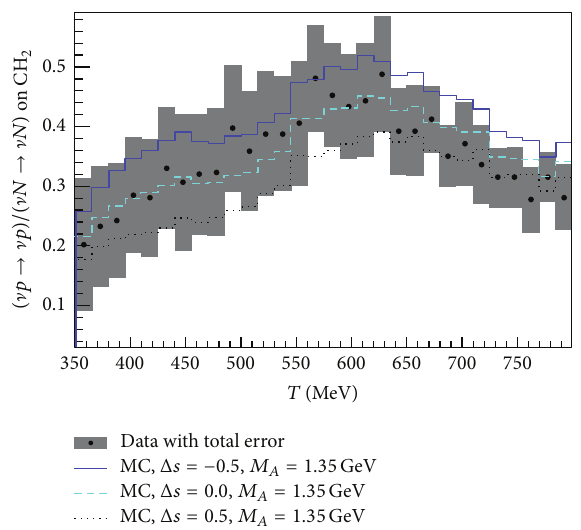
Figure 6: (Color online) The ratio of ] 𝑝 → ] 𝑝 to ] 𝑁 → ] 𝑁 as a function of the reconstructed total kinetic energy of nucleons